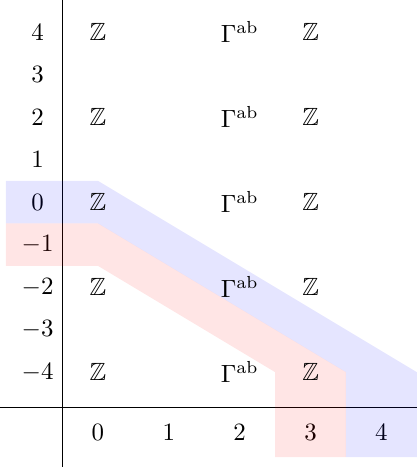
E 1 to K 0 ( S 3 = (cid:0)) (blue, on top) and 2 =